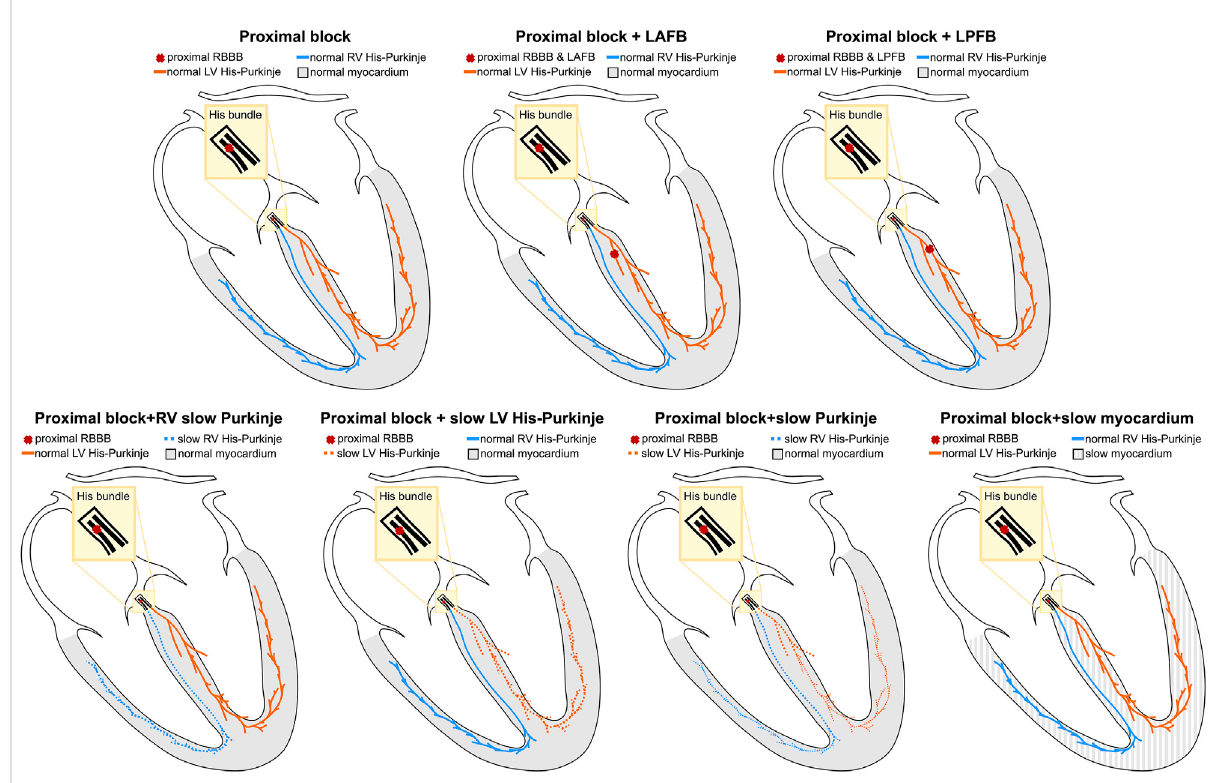
FIGURE 1 Schematic representation of conduction disturbances. Conduction blocks in the proximal RBBB or in the left anterior or posterior fascicles are represented by red crosses. The myocardium, the left and the right His-Purkinje system are shown in grey, orange and blue,